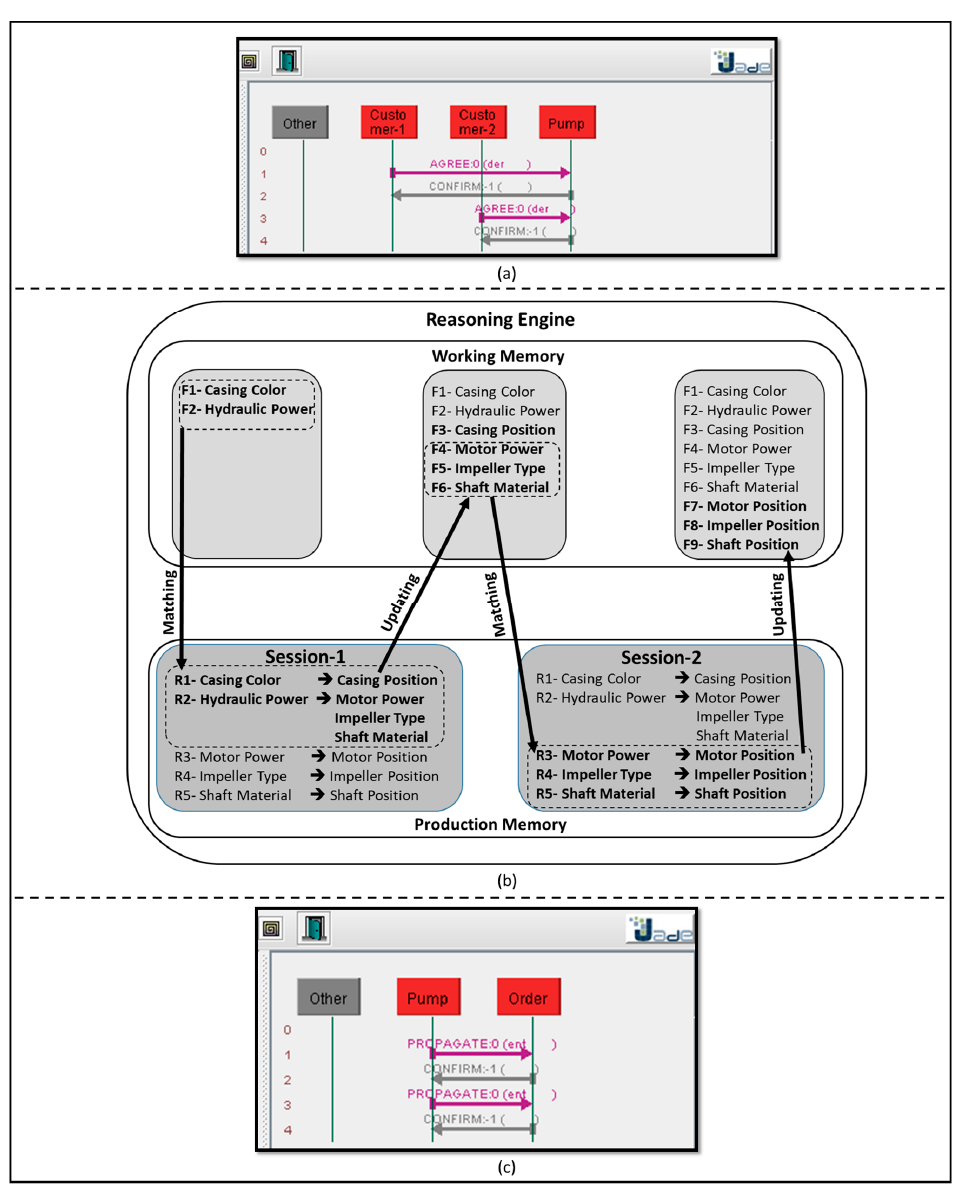
Figure 13. ( a ) JADE interaction among the customer holons and the pump holon; ( b ) Drools reasoning to build a pump details from a customer order; ( c ) JADE interaction between the pump holon and the order